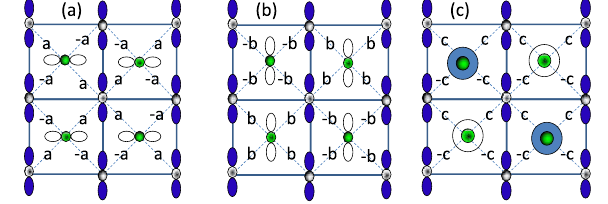
− p couplings. Here, a ¼ j t FIG. 8. The pattern of d yz b ¼ j t , c ¼ j t . x;xz j z;xz j